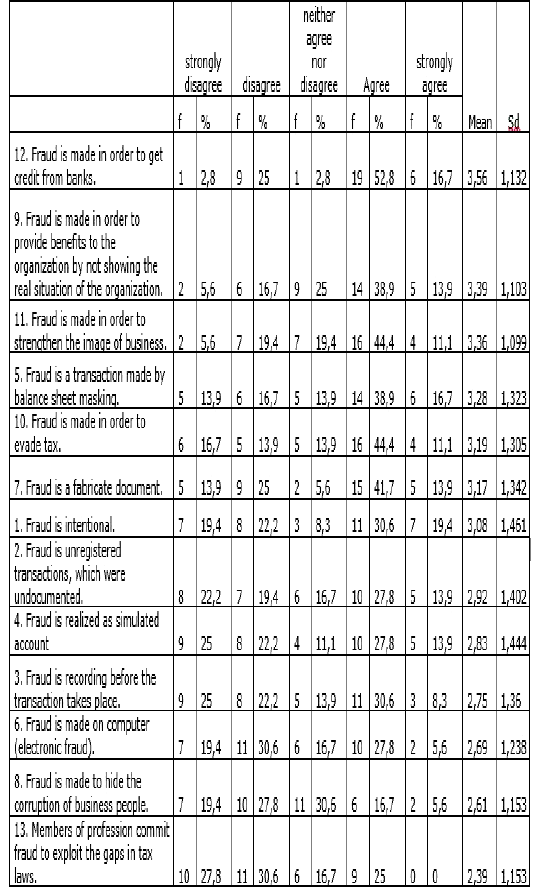
Table 16: Frequency Distribution for Fraud Concept